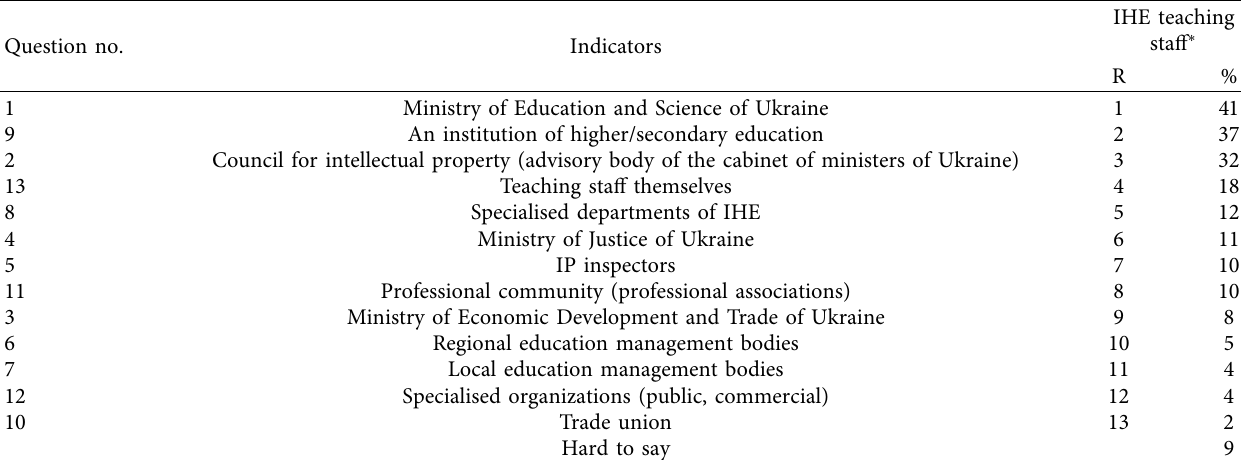
Table 9: Distribution of responsibility for teaching staff’s qualification enhancement in IPR protection. Question no.